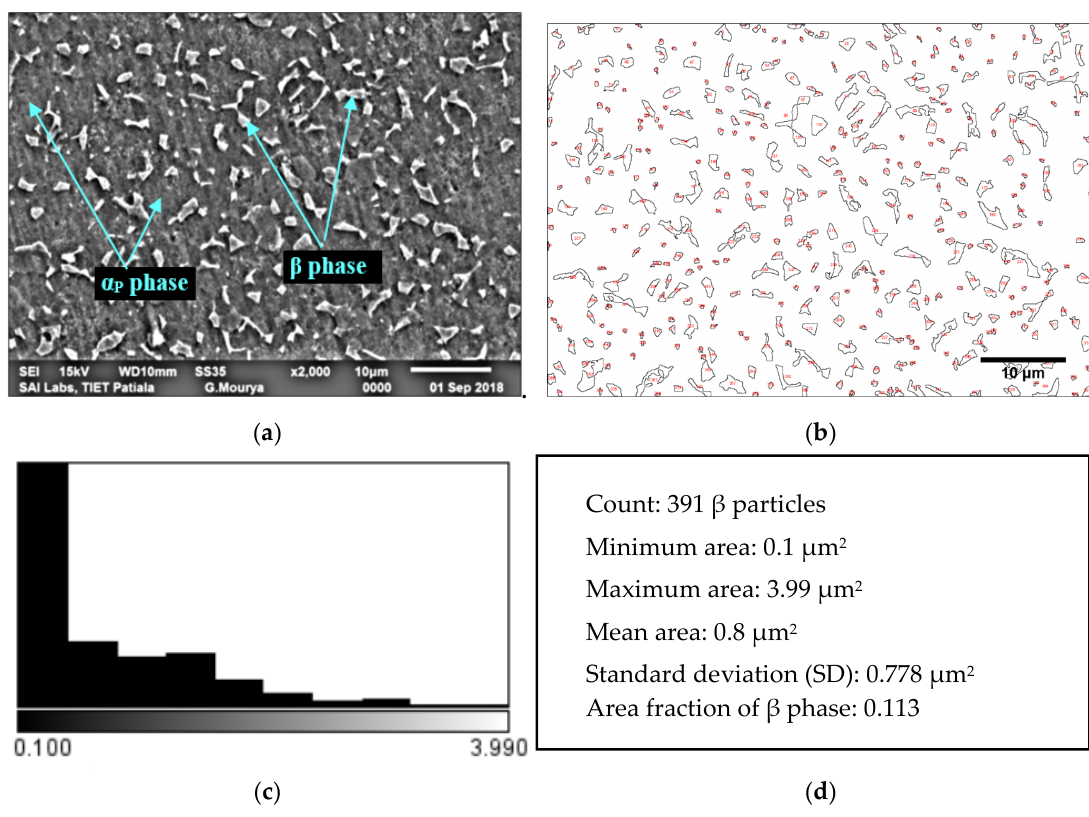
Figure 2. Microstructure of ( a ) MA Ti-6Al-4V ELI; ( b ) threshold image of MA Ti-6Al-4V ELI; ( c ) β phase distribution and ( d ) statistical analysis of β phase.